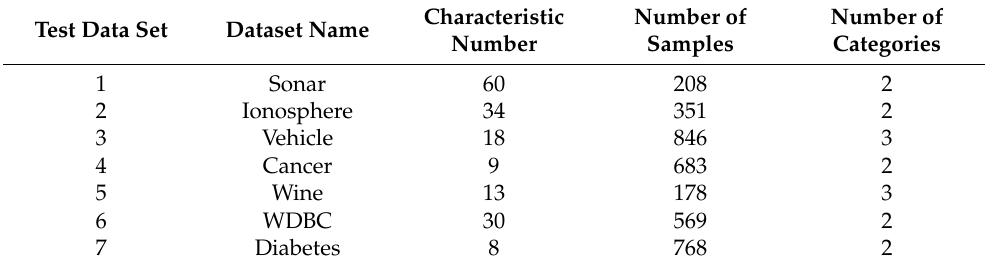
Table 2. Test datasets.